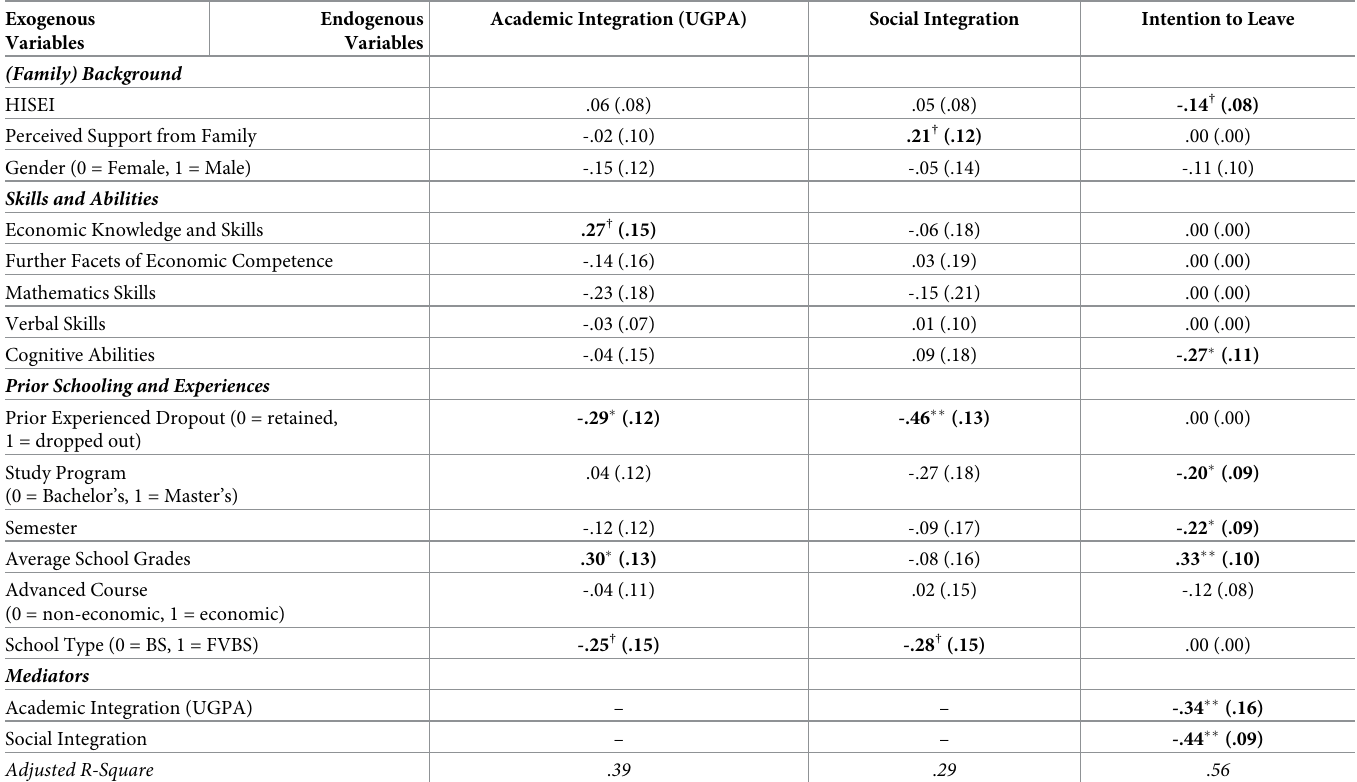
Table 9. Results of SEM to predict the intention to leave economics (direct